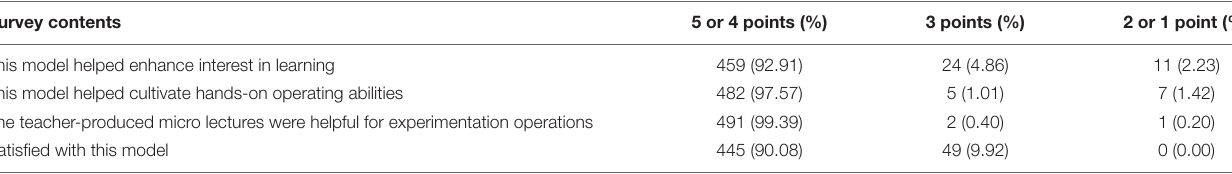
FIGURE 2 | Comparison of the distribution of the experimentation operating examination results for the two groups of students. In the teaching reform group, the proportion of the “=90-point score segment” was significantly higher, and the failure rate was significantly lower. * P < 0.05 vs. control. TABLE 2 | Student evaluation of the degree of identification with the “Internet Plus” model ( n = 494).